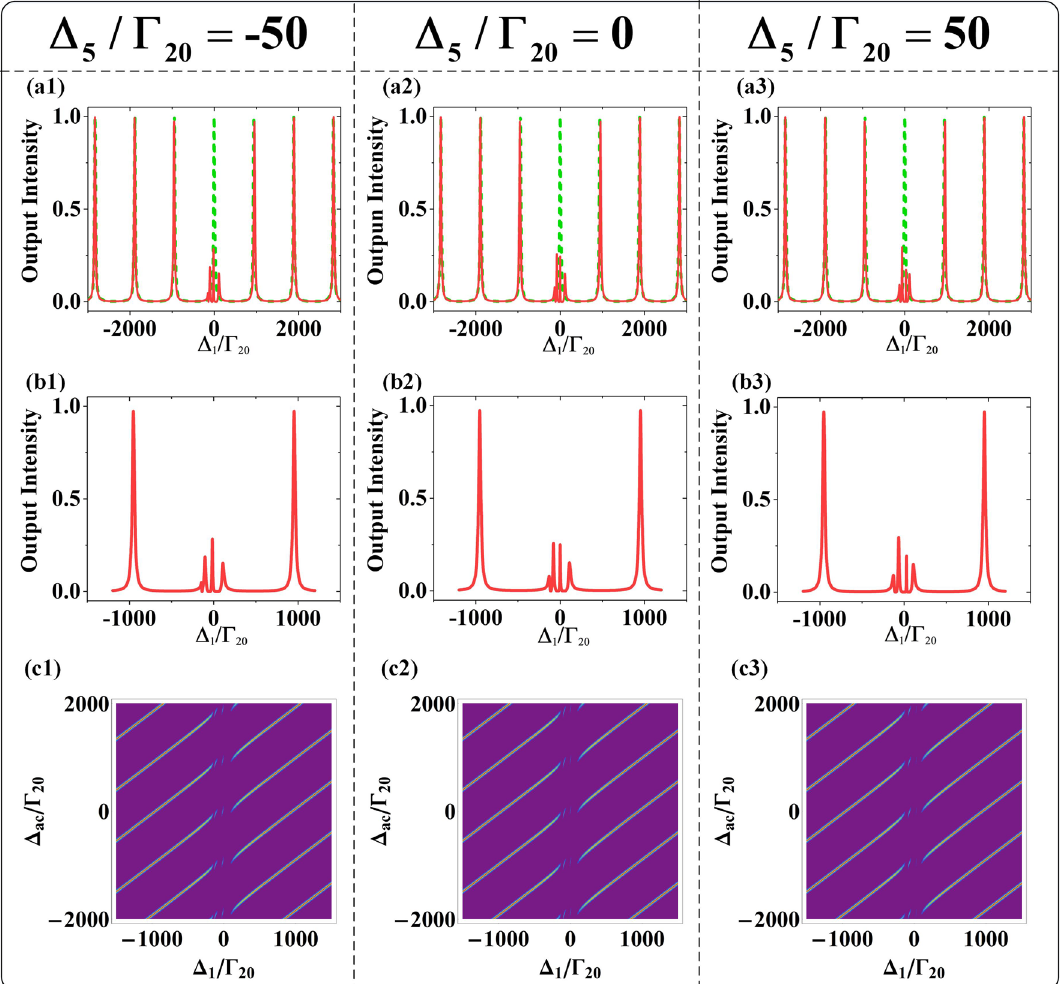
Figure 4. ( a1 )–( a3 ) The high-order modes intensity transmission coefficients of FWM signal of nested type at 0 MHz . The solid curves represent the transmission peaks with different parameters. The dashed curves (cid:31) ac = are the transmission spectra of empty cavity. ( a1 ) With � 5 /Ŵ 20 50 . ( b1 )–( b3 ), The details of FWM intensity transmission coefficients in the narrow regions of high- � 5 /Ŵ 20 = order modes corresponding to ( a1 )–( a3 ). ( c1 )–( c3 ) The avoided-crossing plots with both scanning (cid:31) 1 and (cid:31) ac corresponding to ( a1 )–( a3